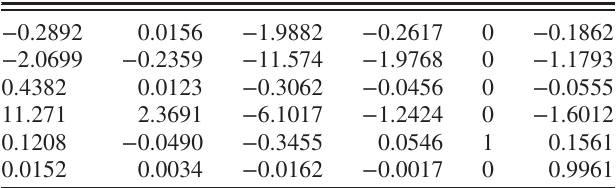
TABLE V. Transfer matrix R of C3 ( j R j ¼ 1 . 00